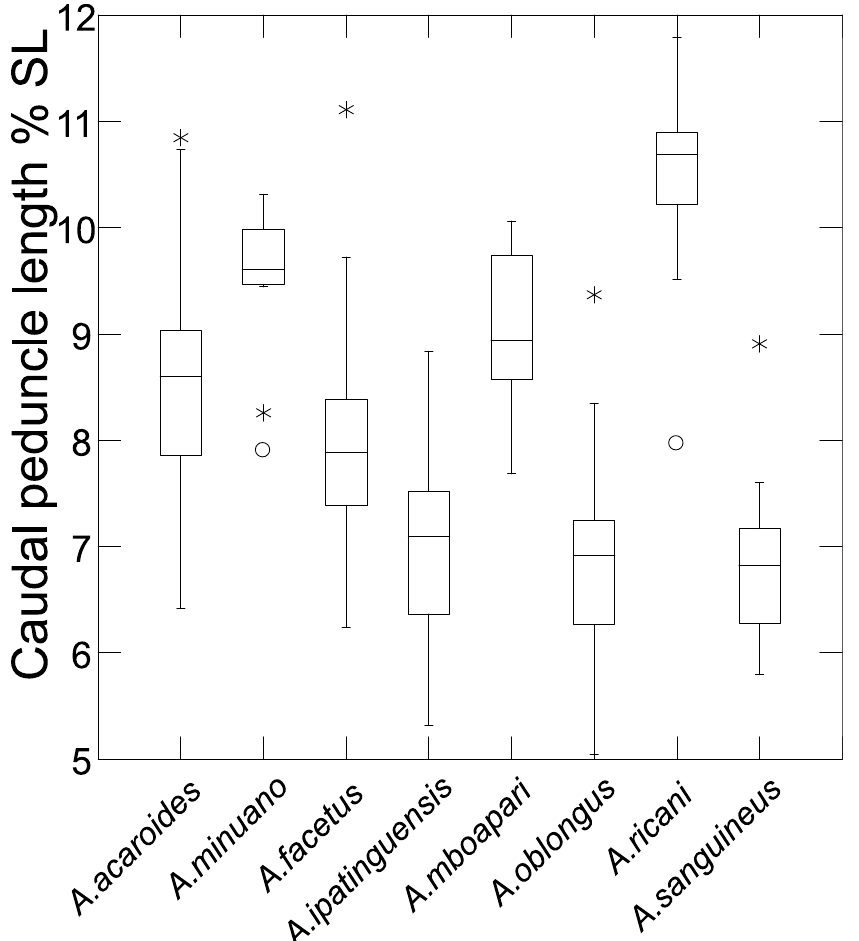
Fig 13. Phylogenetic tree of species of Australoheros based on Bayesian inference of mt-cyb sequences. Coloured rectangles and names to the right cover valid species; names of nominal species identified by locality contained within